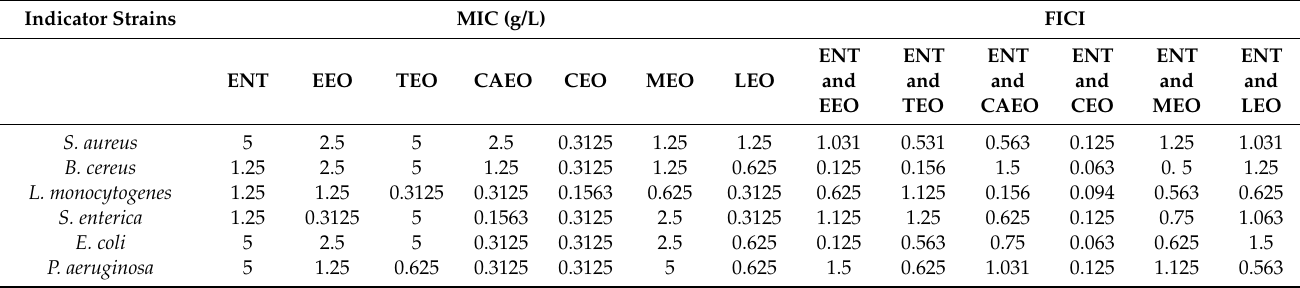
Table 1. The minimum inhibitory concentration (MIC) and fractional inhibitory concentration index (FICI) of enterocin Gr17 and essential oils (eugenol [EEO], thymol [TEO], carvacrol